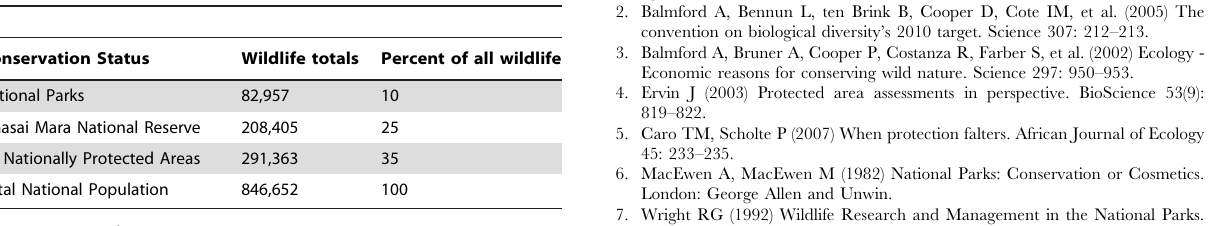
Table 4. Percentages of wildlife found within protected areas relative to national totals, averaged for the